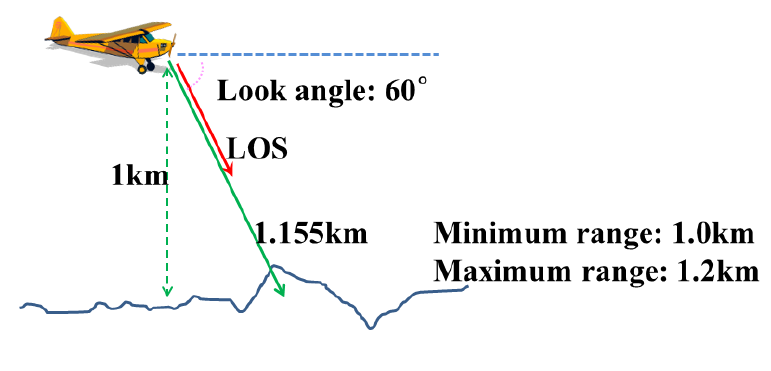
Figure 14. Scenario of the LADAR system for simulation. The aerial platform is assumed to be in the midair at 1 km with the speed of 0 m/s. Besides, the LADAR sensor is mounted obliquely to look targets and background